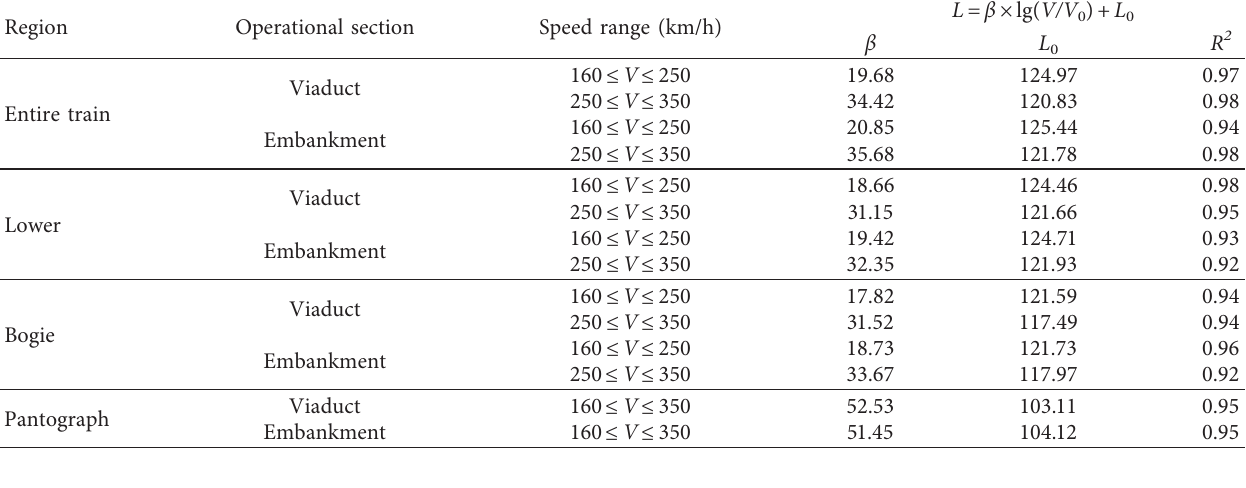
Table 3: Linear fitting results of radiating sound power level in typical